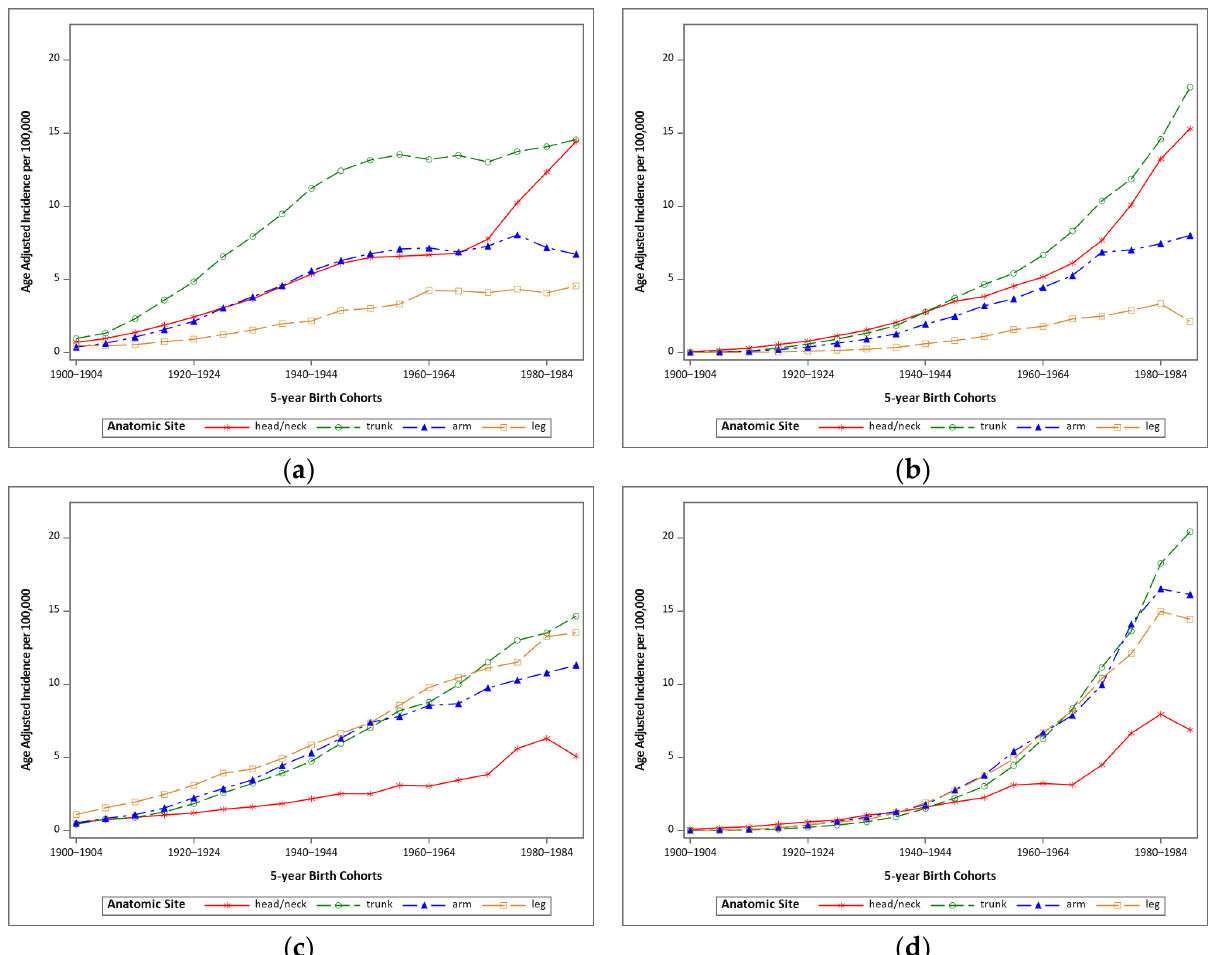
Figure 1. Age-adjusted incidence of melanoma for 5-year birth cohorts by anatomic site of original lesion. ( a ) malignant melanoma in males, ( b ) in situ melanoma in males, ( c ) malignant melanoma in females, ( d ) in situ melanoma in females. Data from SEER 9, 1975–2017.